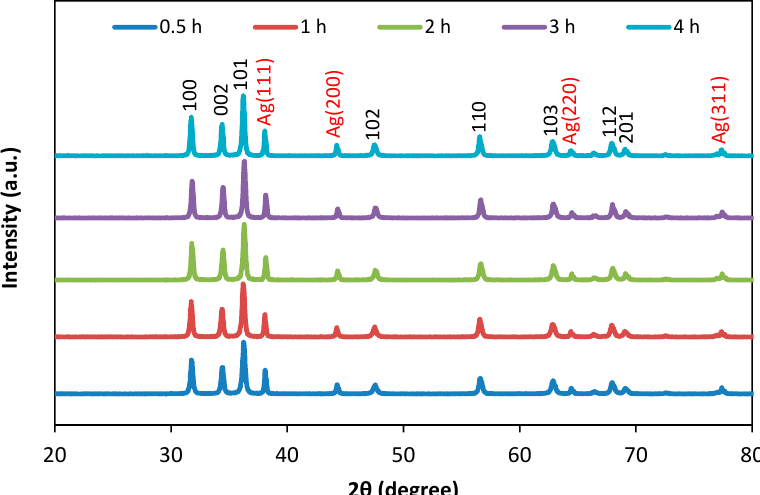
Figure 3. XRD patterns of Ag/ZnO synthesized at different calcination times.